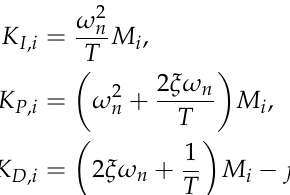
Figure 3 highlights the closed loop dynamics achieved with the derived